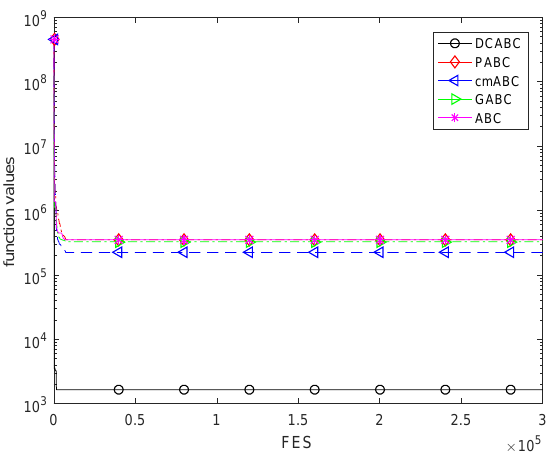
Figure 5. Convergence curves of five algorithms for f 8 with D = 30. (The optimal value of f 8 is